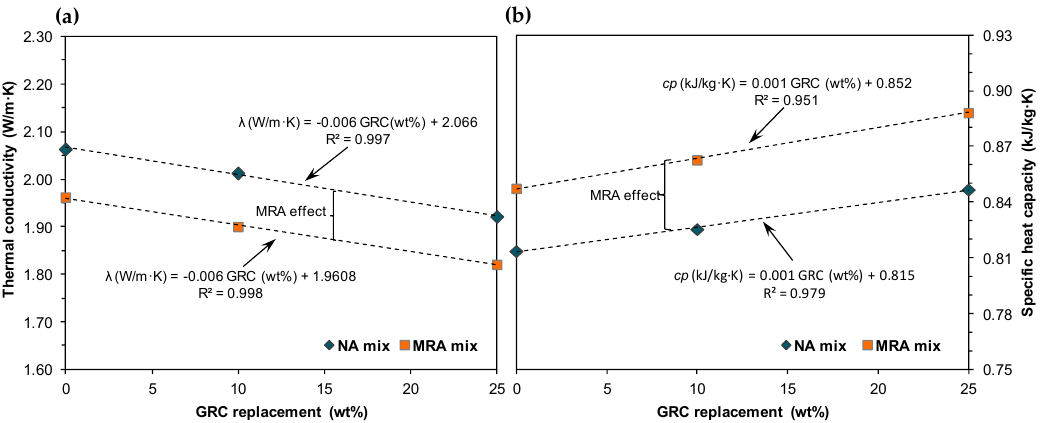
Figure 6. ( a ) Thermal conductivity and ( b ) specific heat capacity as a function of the GRC replacement ratio.